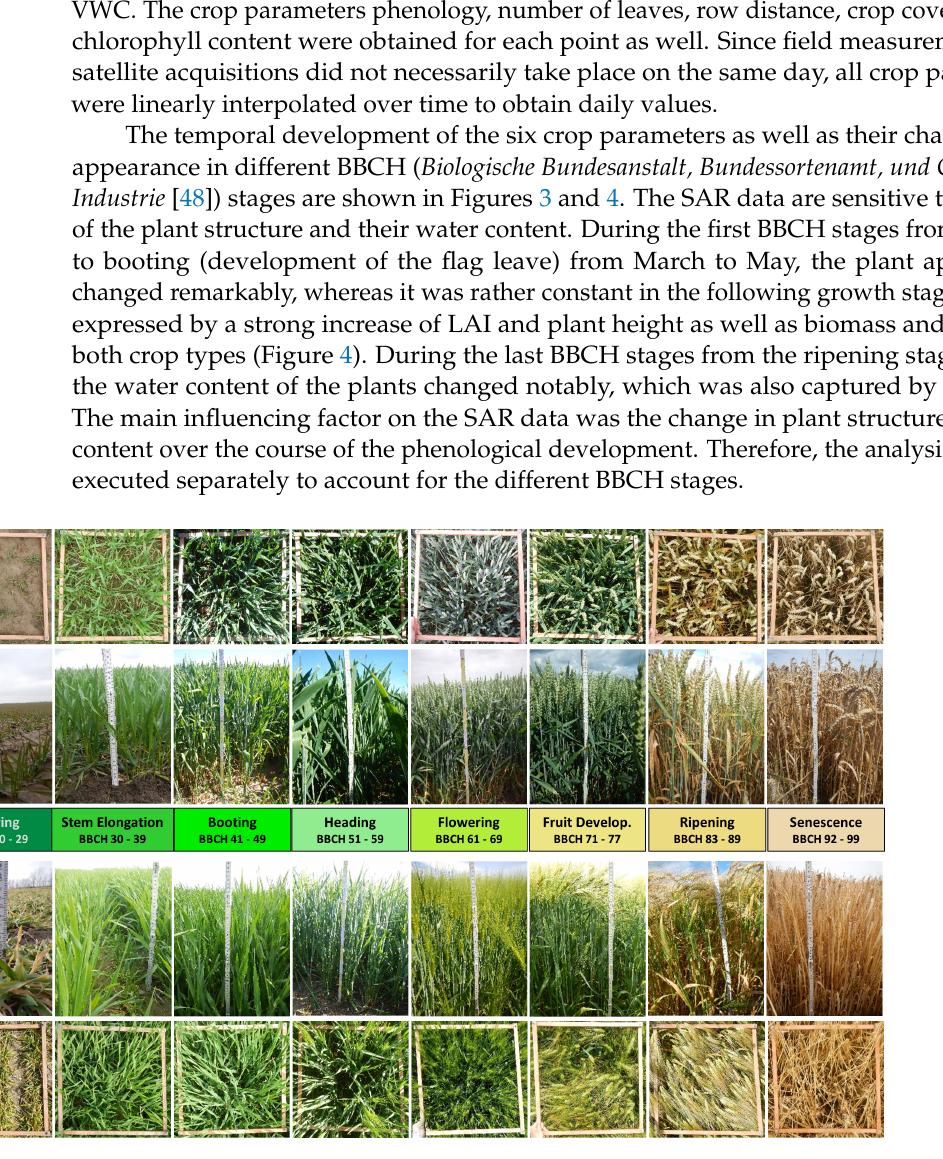
Figure 3. Characteristic appearance of wheat and barley in different BBCH ( Biologische Bundesanstalt, Bundessortenamt, und CHemische Industrie )